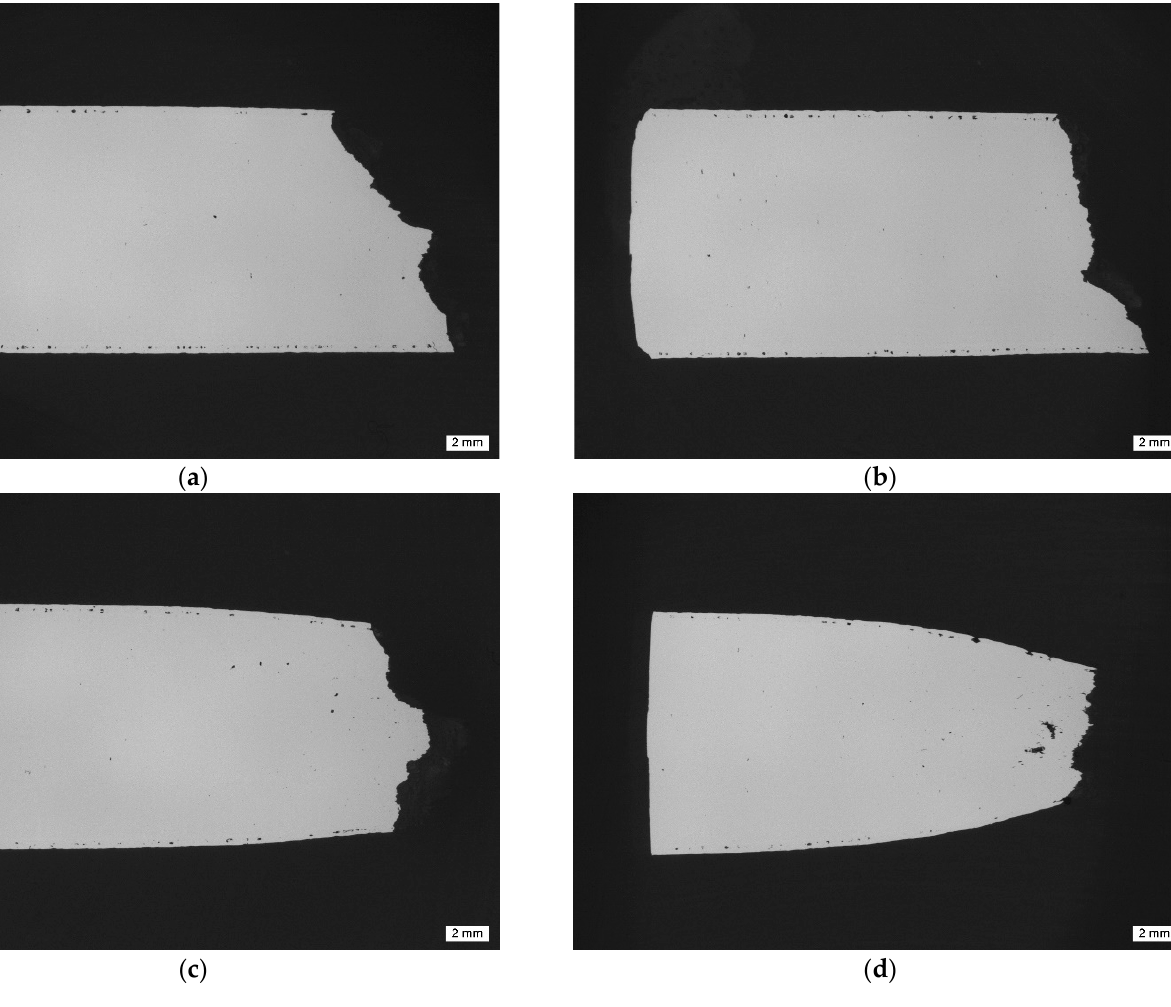
Figure 6. Macroscopic images of unetched metallographic sections of tensile test samples of polar angle 0° tested at increasing temperatures: ( a ) RT, ( b ) 125, ( c ) 250 and ( d ) 450 °C. The images provide an impression of the level of porosity as well as highlighting the necking, which increases with the increasing test temperature from ( a – d ). The sample tested at 450 °C also showed evidence of pore growth in the plastic region adjacent to the fracture location.